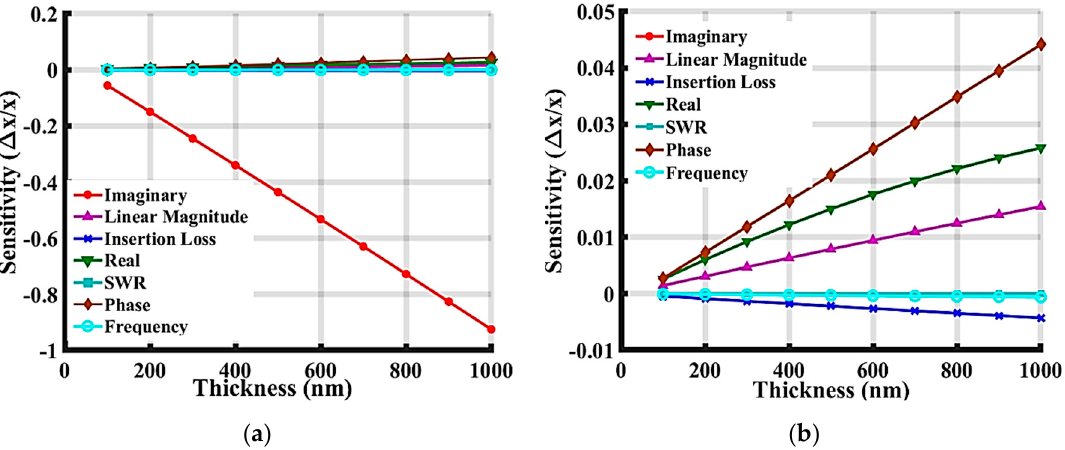
Figure 14. The simulated results based on different sensitivity parameters for SAW devices with 50 nm IrO 2 layer and a ZnO layer of varied thicknesses. ( a ) Full view of the plot, and ( b ) zoomed figure without Imaginary data.